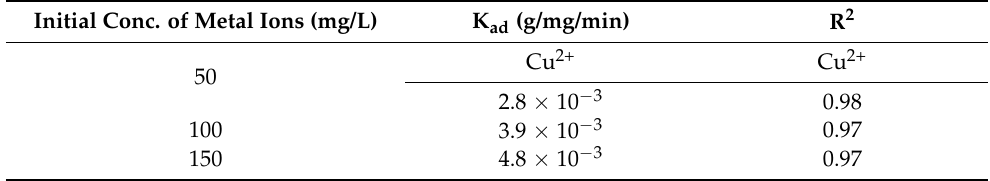
Table 2. Comparison of Langmuir and Freundlich isothermal adsorption-related parameters of the MSH@MA NPs materials for Cu 2+